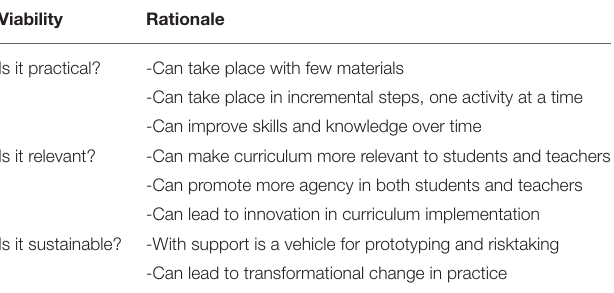
TABLE 8 | Study viability as related to implementability (McKenney et al., 2006).